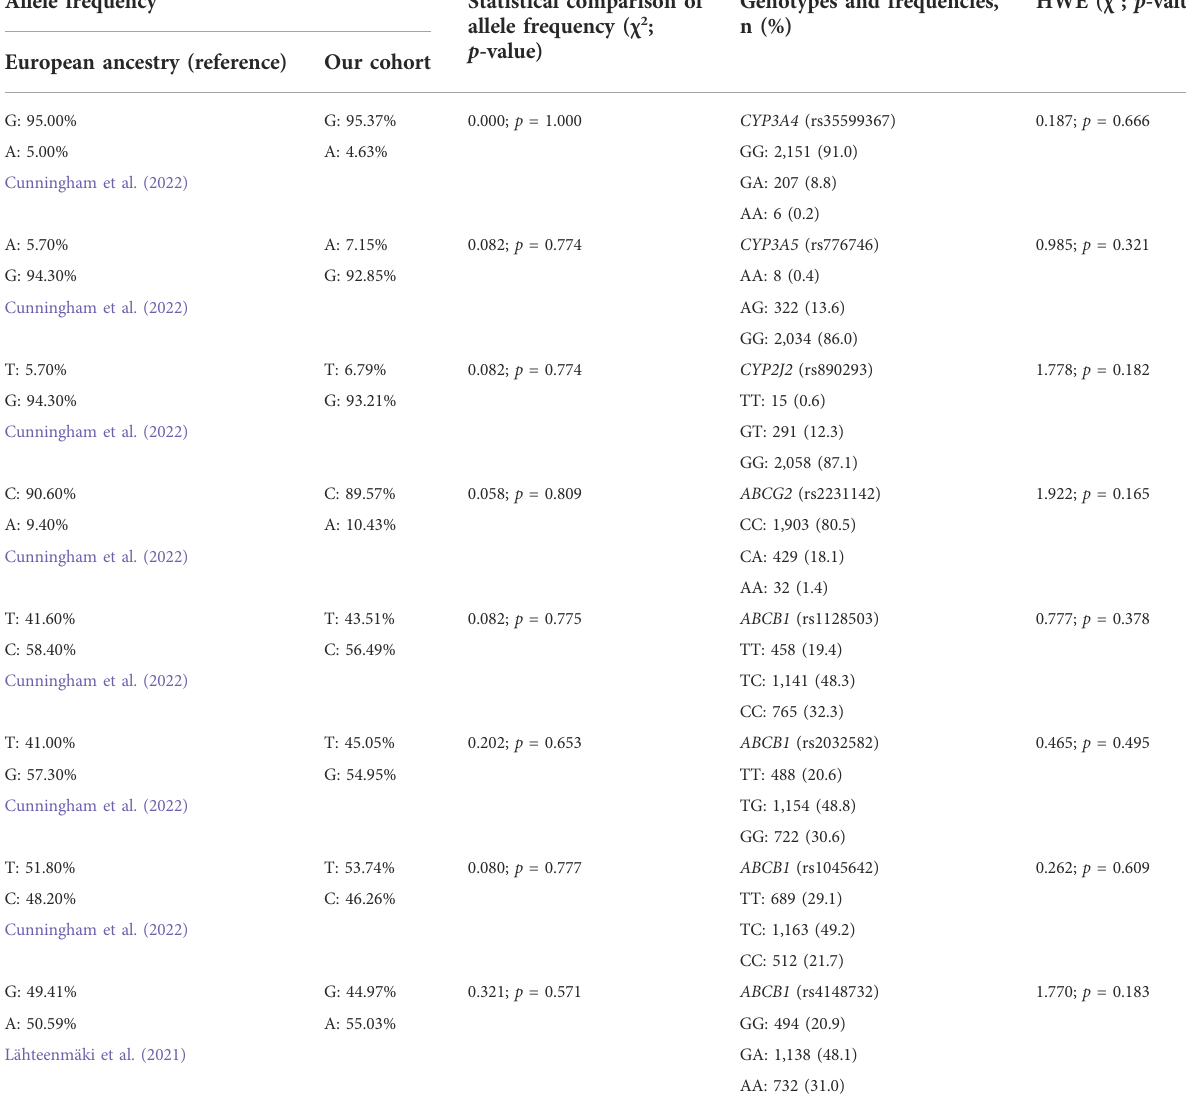
TABLE 3 Genotype and allele frequency, and Hardy-Weinberg equilibrium (HWE) assessment of the eight PK-related genetic variants. Allele